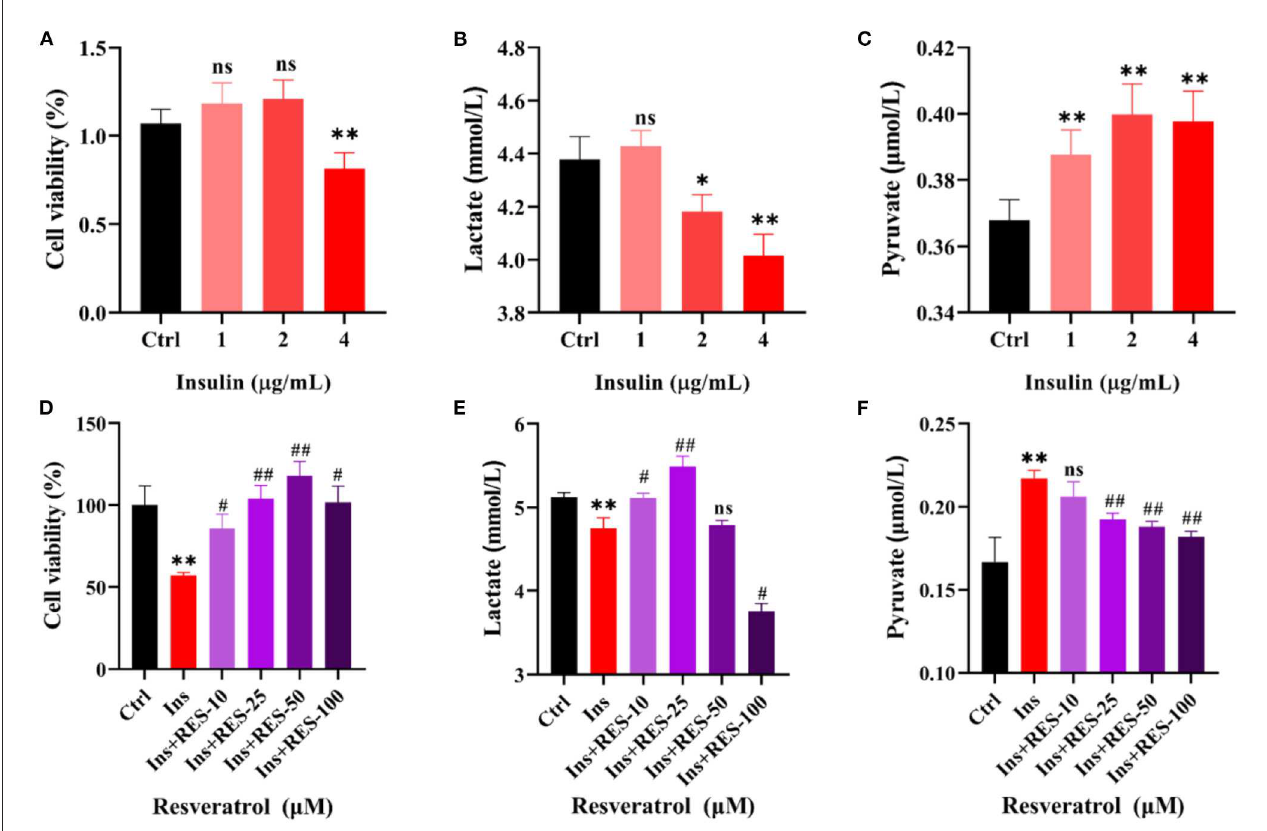
FIGURE2 RES can improve the glycolysis process of insulin-treated KGN cells. Cell viability of KGN cells in which treatment with insulin (A) or insulin and RES (D) was determined using cck-8. The level of lactate in KGN cells, which treated with insulin (B) or insulin and RES (E) using ELISA. The level of pyruvate in KGN cells, which treated with insulin (C) or insulin and RES (F) using ELISA. *ctrl vs. insulin; # insulin vs. insulin + RES. Significant differences between the groups are shown as * P < 0.05, ** P < 0.01, # P < 0.05, and ## P <